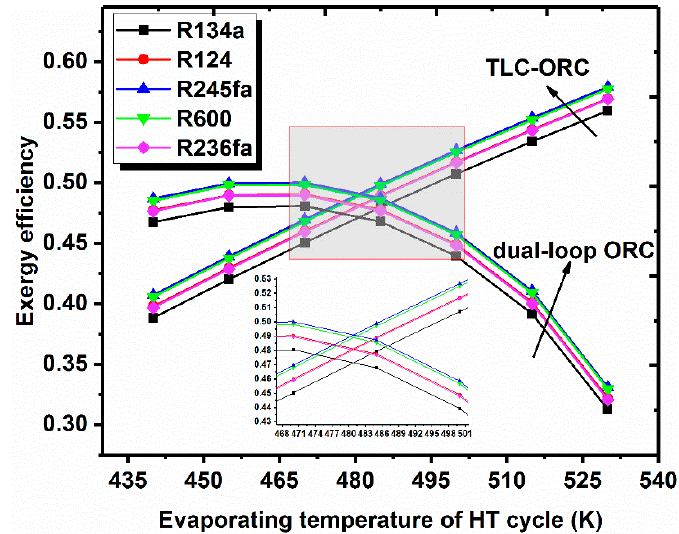
Figure 12. Comparison of thermal efficiency between the two systems under different LT working fluids and T HT,evap .